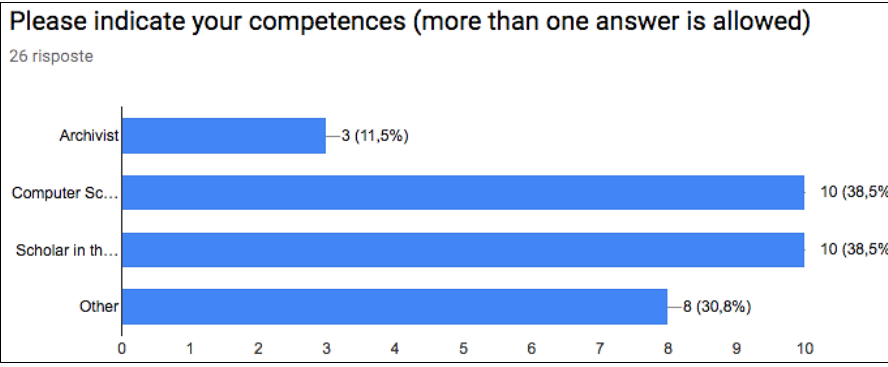
Figure 5. User areas of